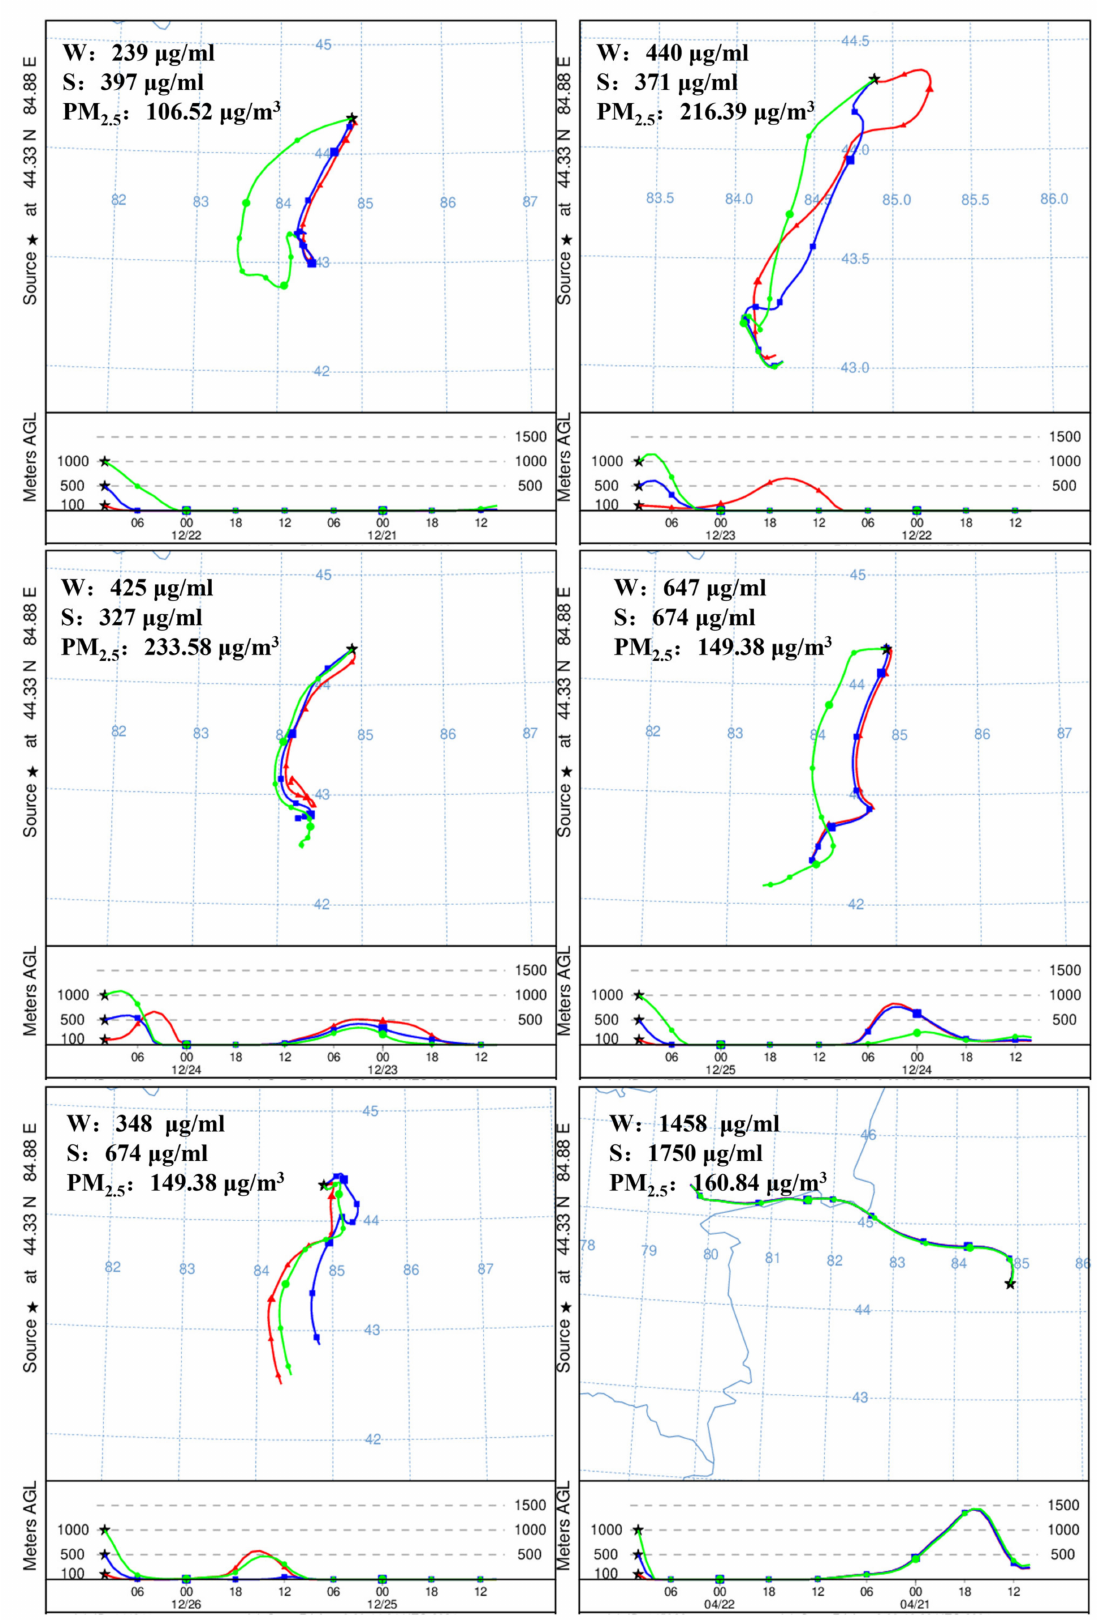
Figure 7. Forty-eight hour back trajectories of air masses arriving at the sampling